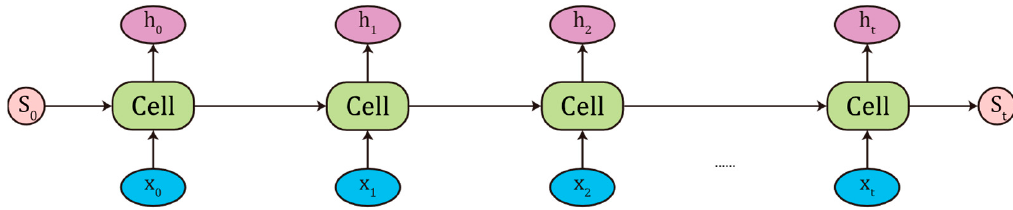
Figure 3. Unrolled RNN chain-loop structure.